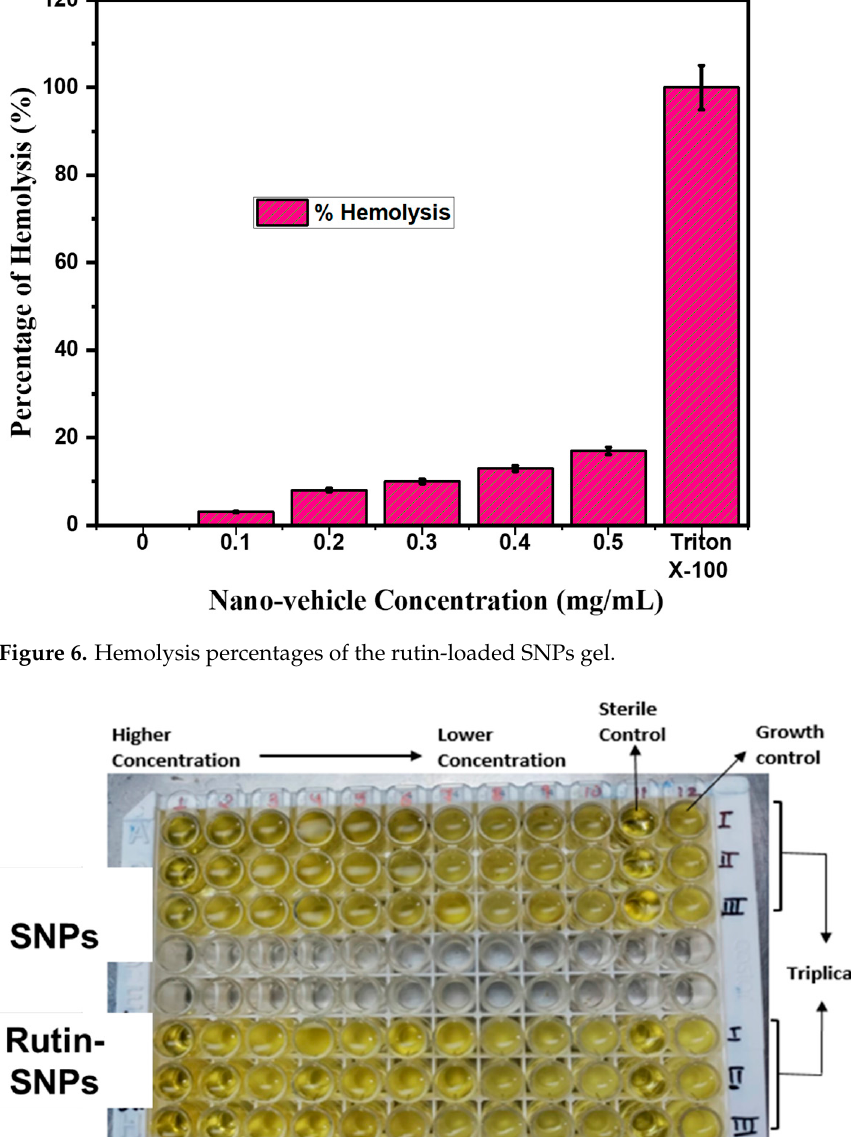
Figure 6. Hemolysis percentages of the rutin-loaded SNPs gel.